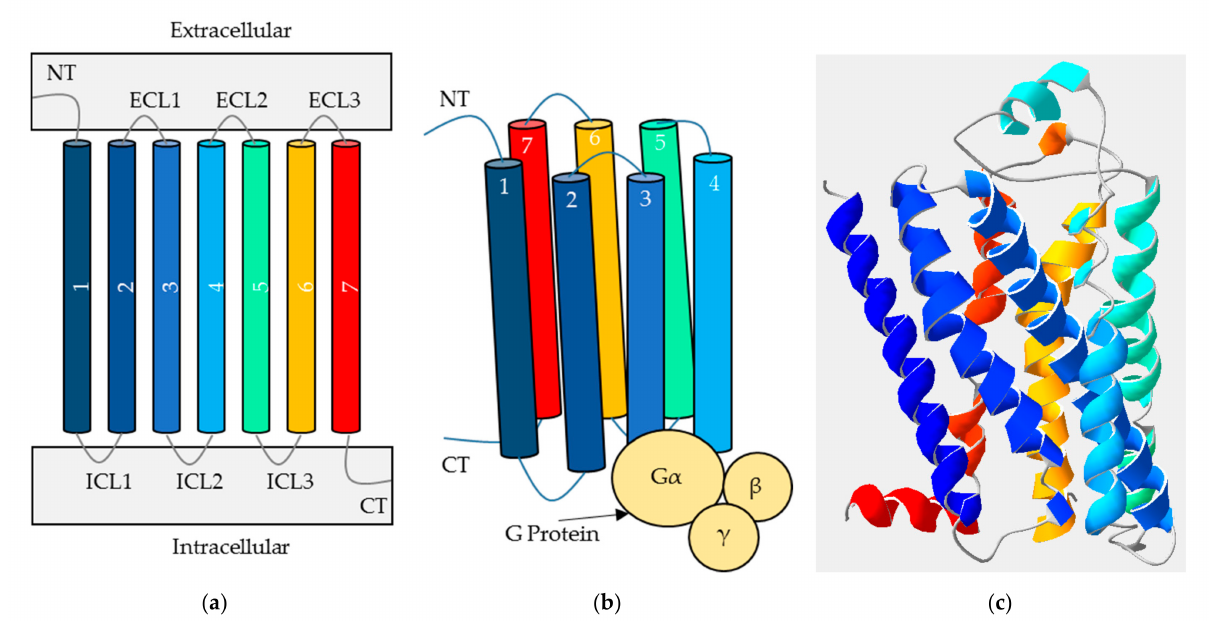
Figure 1. The typical structure of a G protein-coupled receptor (GPCR). ( a ) A two-dimensional representation of a GPCR showing its extracellular N terminus (NT), seven transmembrane helices (TM1-7, multicoloured), three extracellular loops (ECL1-3), three intracellular loops (ICL1-3) and intracellular C terminus (CT). ( b ) A three-dimensional representation of the transmembrane bundle, with helices labelled 1–7 and intracellular recruitment of a G protein (yellow circles). ( c ) An example of a resolved GPCR crystal structure for context ( β 2AR receptor, PDB code 6PS0)